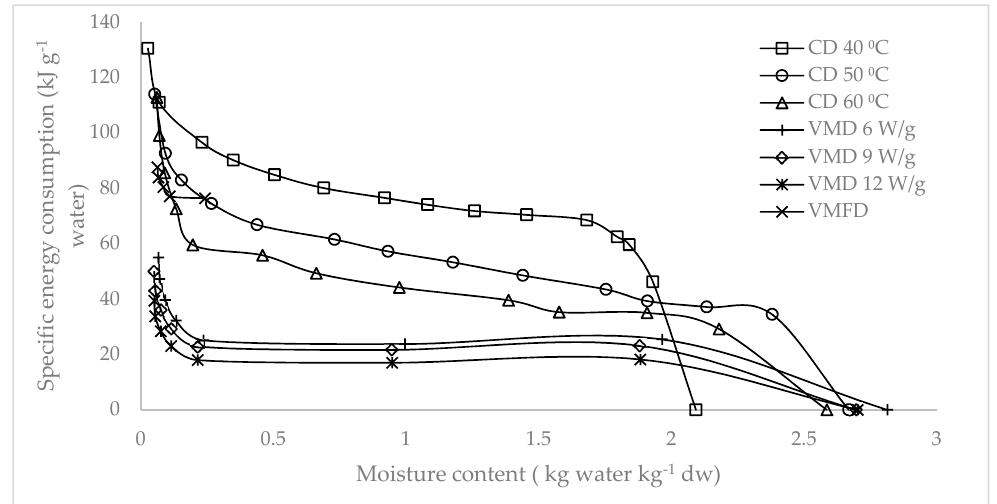
Figure 7. Specific energy consumption of S. crispus leaves per gram of fresh weight dried using CD, VMD, and CPD-VMFD.